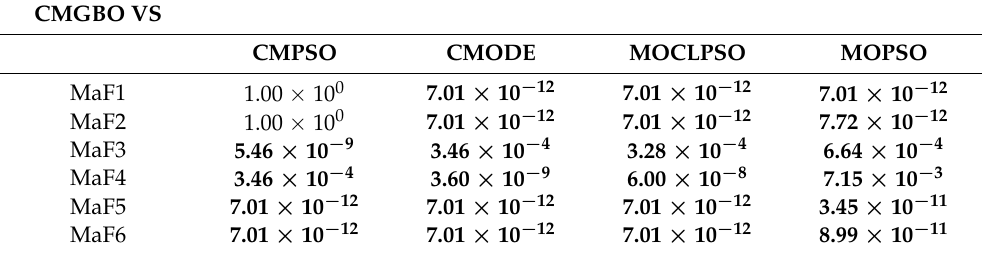
Table 7. The p -values of the Wilcoxon test for the IGD